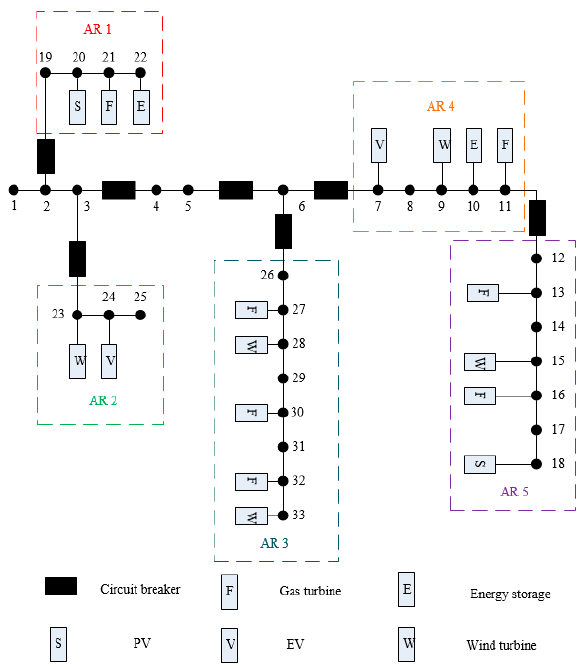
Figure 5. IEEE-33 study system.